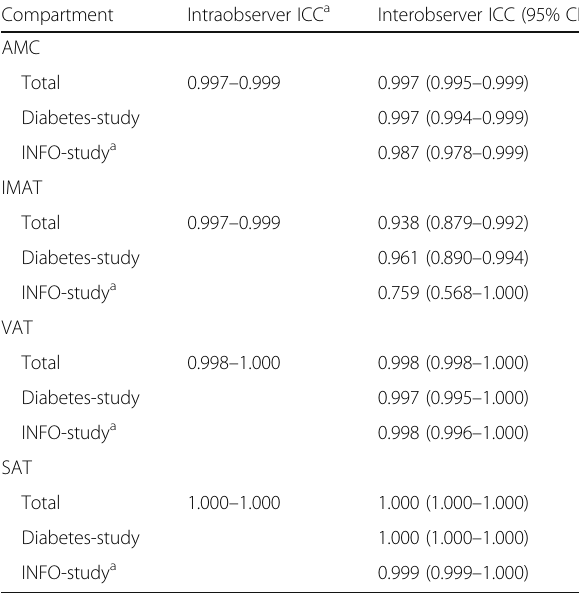
Table 4 Inter- and intraobserver variation measurements